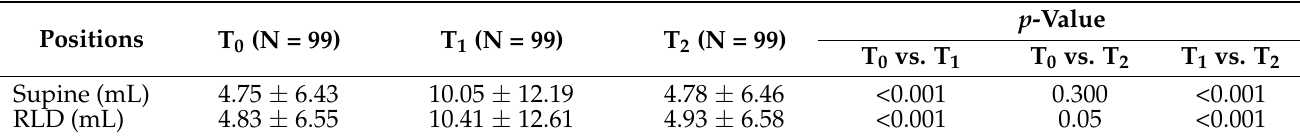
Table 2. Mean RGV taken in supine and